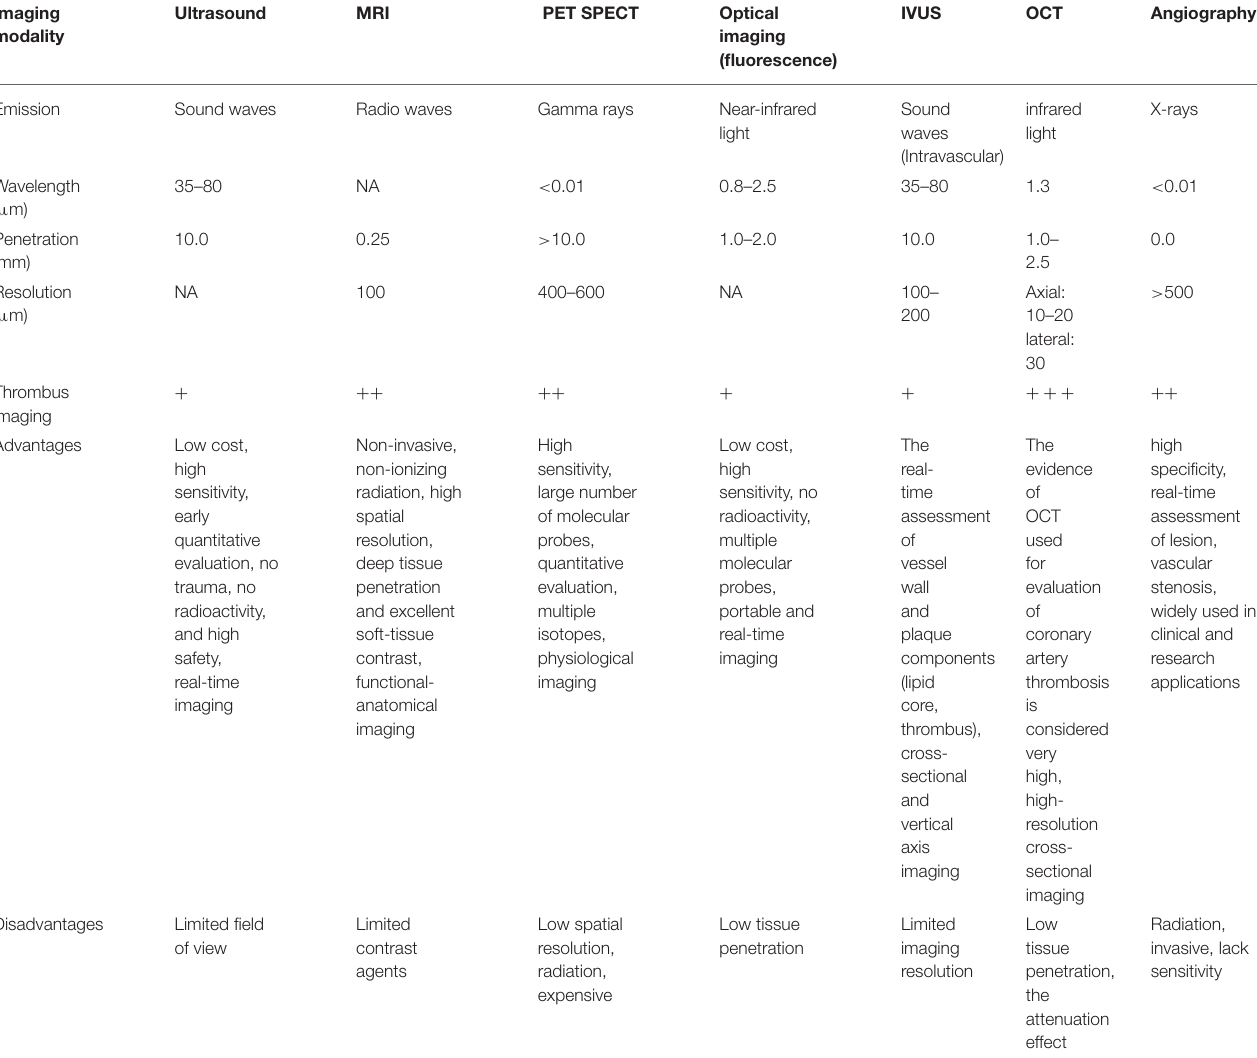
TABLE 2 | Comparative overview for different imaging modalities. Imaging